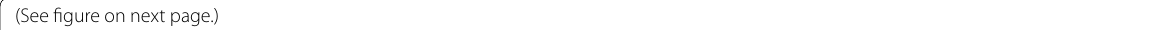
figure on next Fig. 1 a Map of the study area. Solid triangles and triangles outlined with thin lines indicate the stations used in the source inversion (SI, Fig. 3), and the stations used to compare observation and forward ground-motion simulation (FS, Fig. 4), respectively. Triangles outlined with thick lines indicate the stations used in both analyses (SI and FS). The color of the triangles indicates the observation network: blue, red, and green are KiK-net, K-NET, and F-net, respectively. Black and coral stars indicate the epicenters of the 2018 Hokkaido Eastern Iburi earthquake and the aftershock ( M JMA 5.4) at 6:11 JST on September 6, 2018, respectively. Focal mechanisms refer to the F-net moment tensor solutions. The black line denotes the outline of the curved fault model used in the source inversion. Magenta lines denote the surface traces of the active fault zone along the eastern margin of the Ishikari lowland (AIST 2007). b Map view of the curved fault model. Circles denote hypocenters of the aftershocks ( M mainshock. The color of the circles indicates the event depth. c Distribution of strike angle on the curved fault